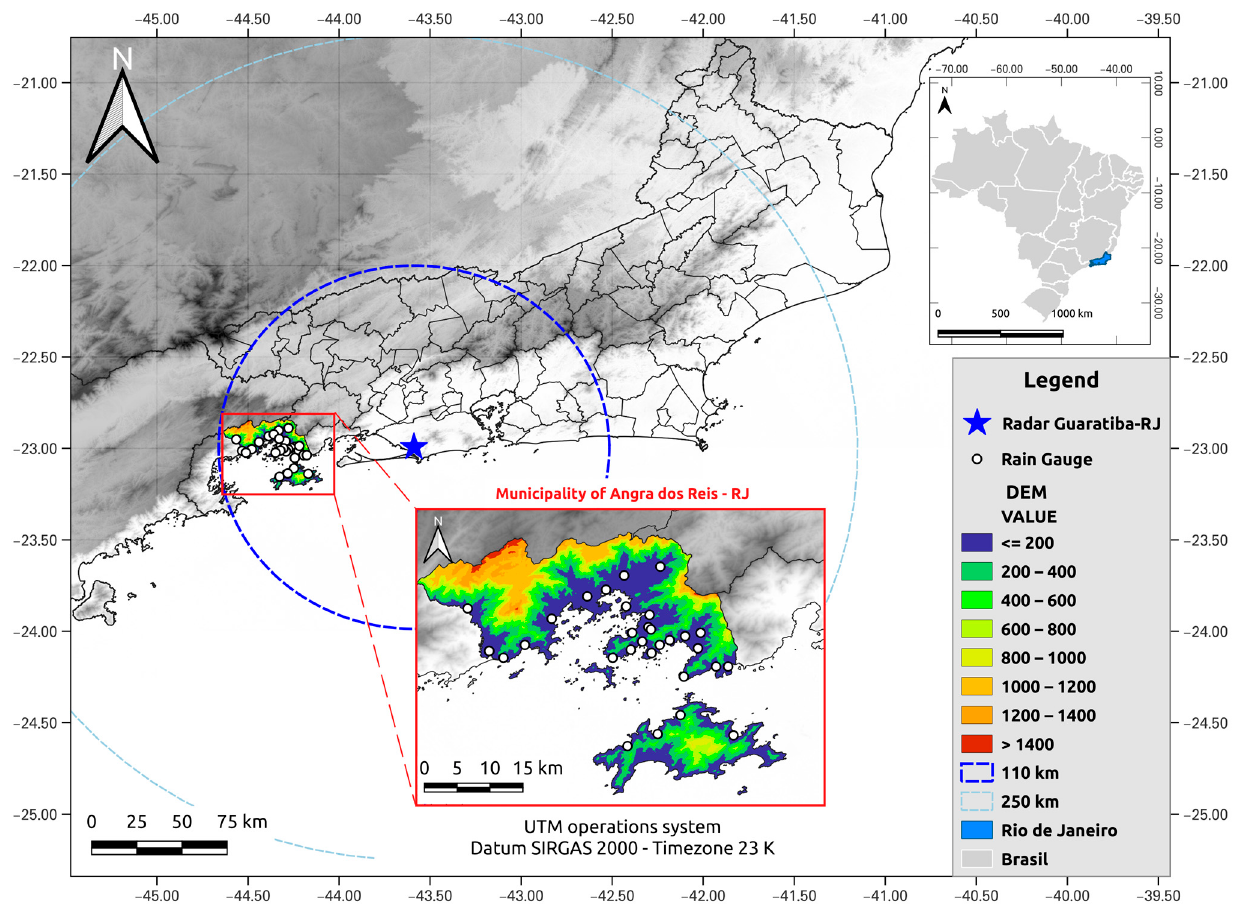
Figure 1. Locations of the rain gauge network of the municipality of Angra dos Reis (RJ) and of Guaratiba’s S-band radar in the state of Rio de Janeiro, Brazil.